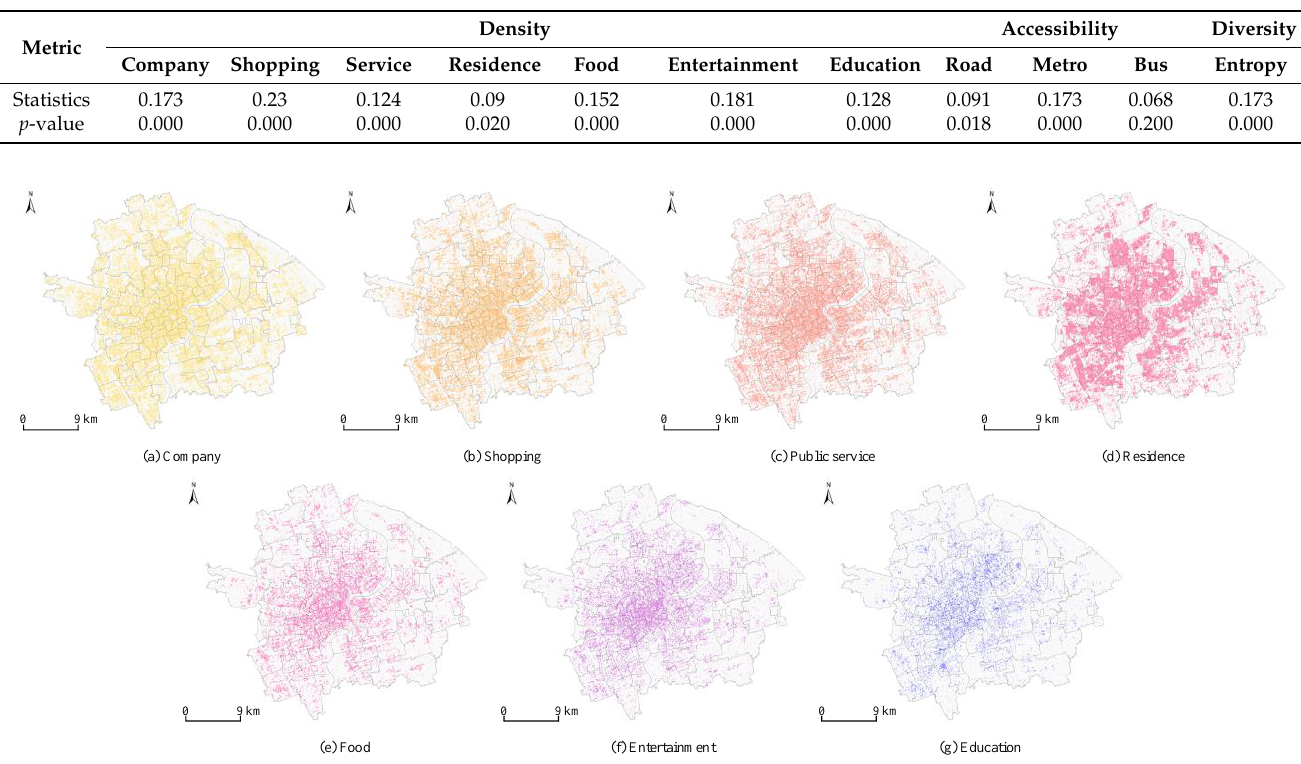
Table A4. K-S test results for built environment factors.